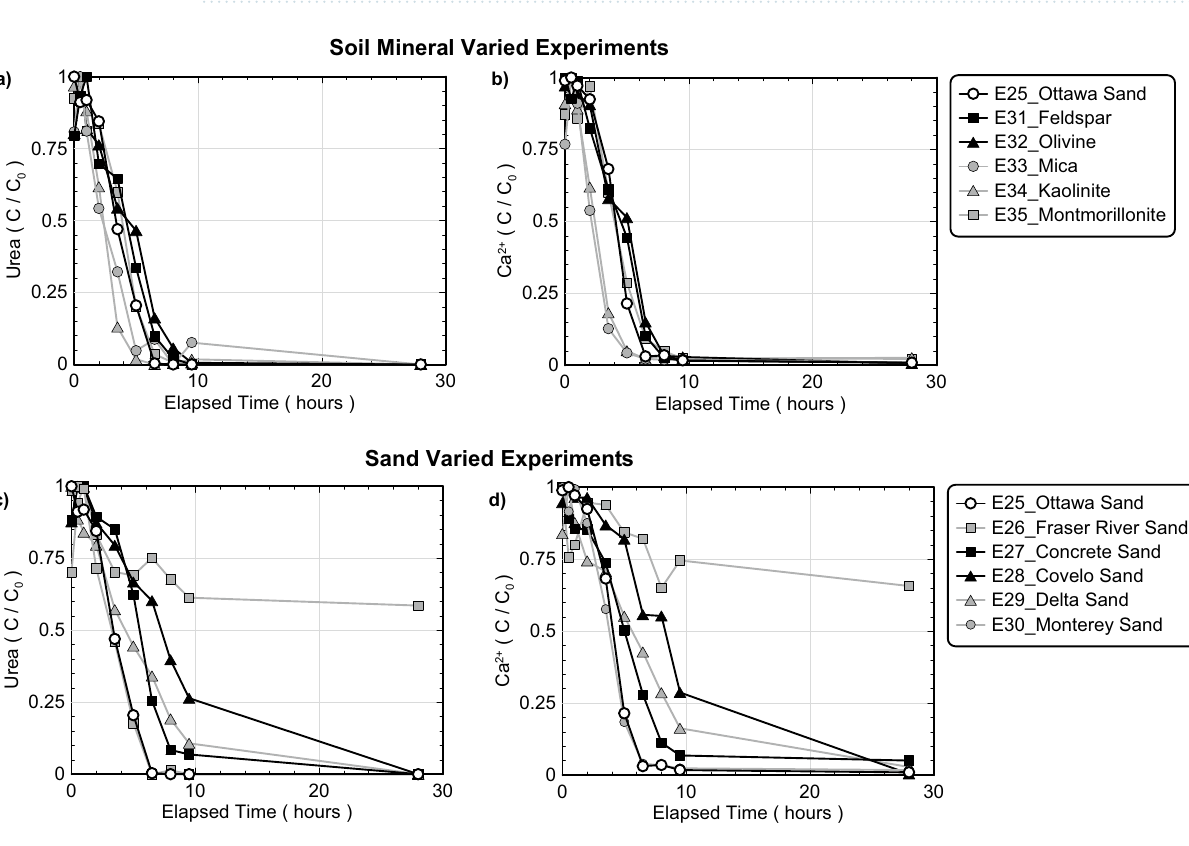
Figure 10. Normalized concentrations of ( a, c ) urea and ( b, d ) Ca 2+ in time for ( a, b ) soil mineral varied experiments and ( c, d ) poorly-graded sand varied experiments. All experiments included the addition of 250 mM urea, 250 mM Ca 2+ , S. pasteurii cells at 8.2 × 10 7 cells/mL, and varying soil